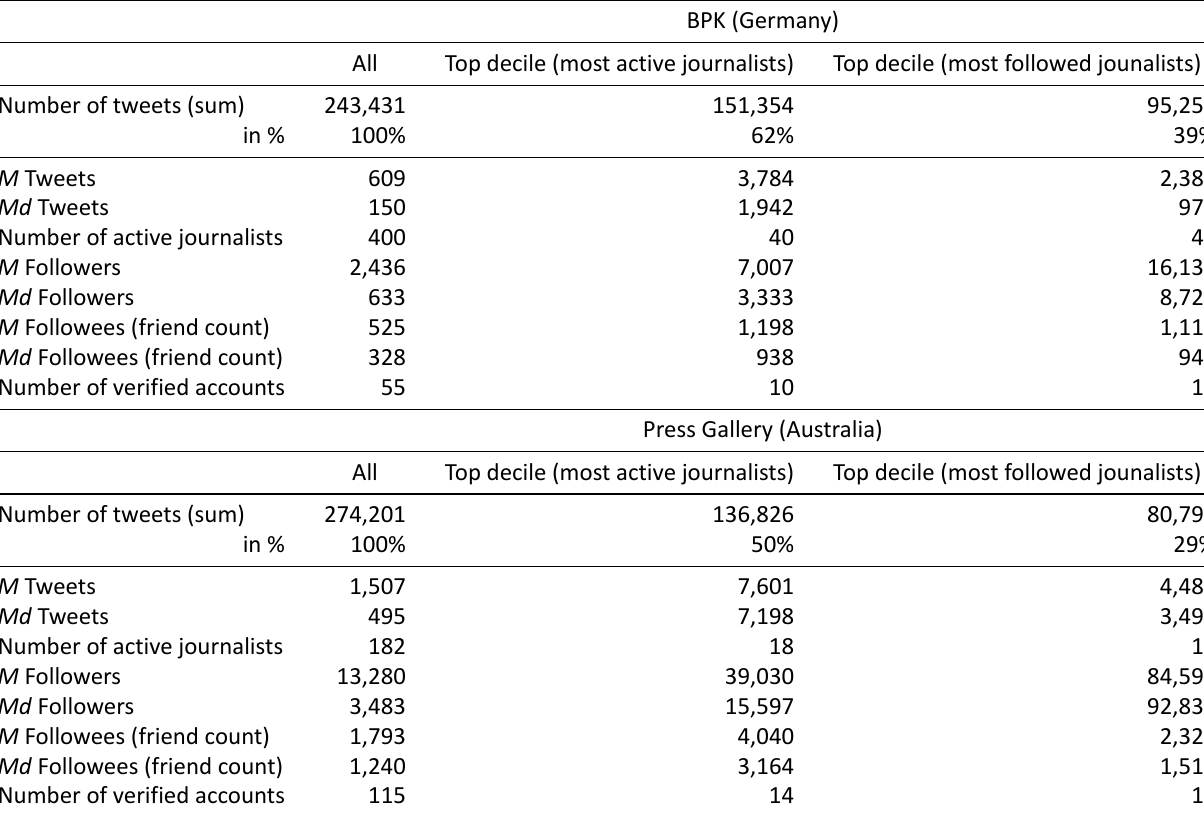
Table 1. Overall metrics for press corps journalists